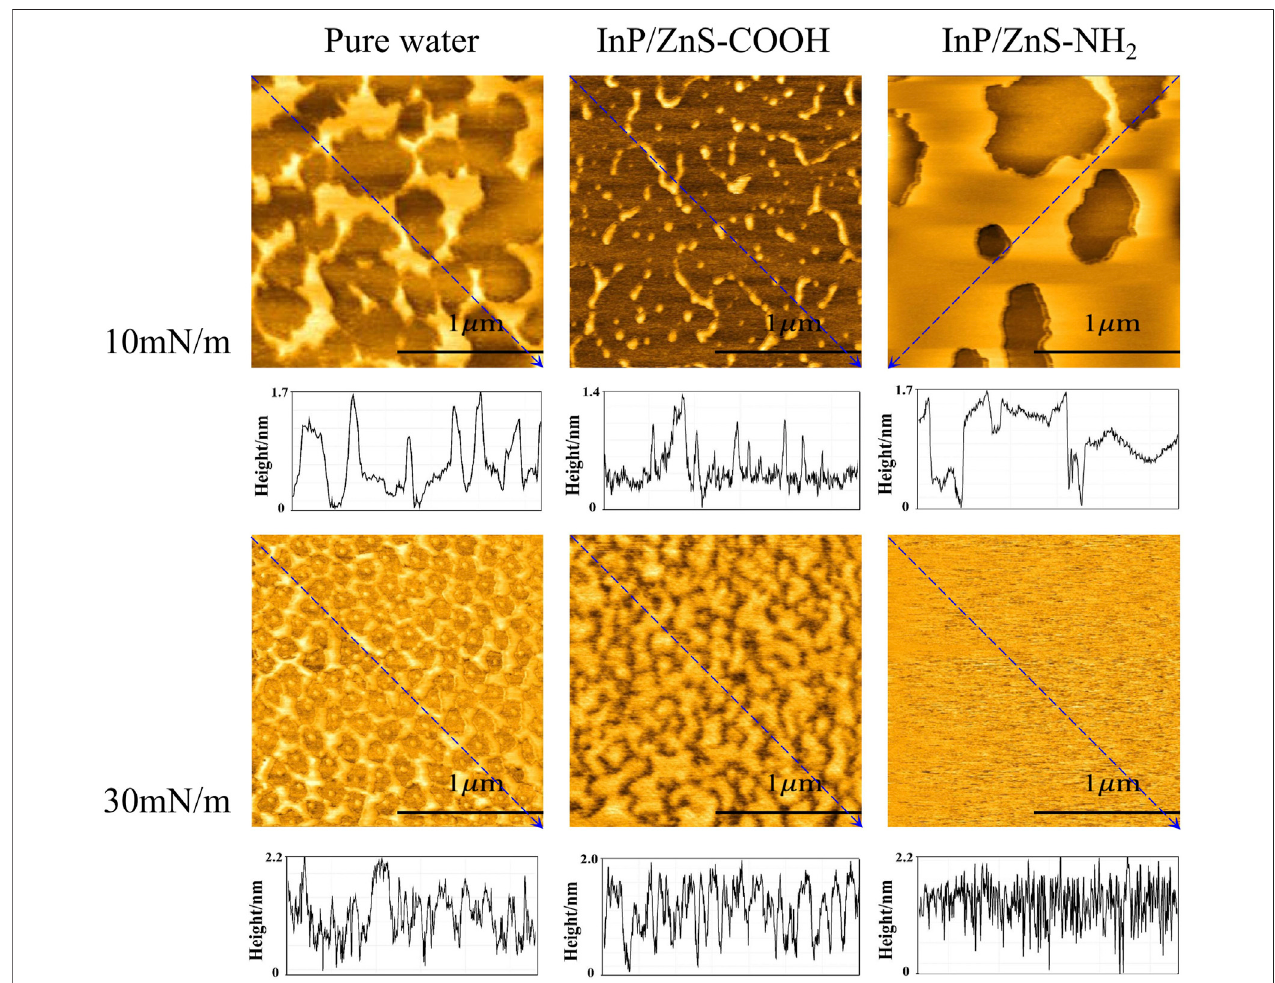
FIGURE 7 | The AFM images (2 μ m × 2 μ m) and height analysis of the DPPC/DPPG (4:1, mol ratio) mixed monolayer fi lms transferred onto the micas, which were spread on the pure water and in the presence of InP/ZnS QDs modi fi ed with − COOH or − NH 2 group at 10 mN/m and 30 mN/m.